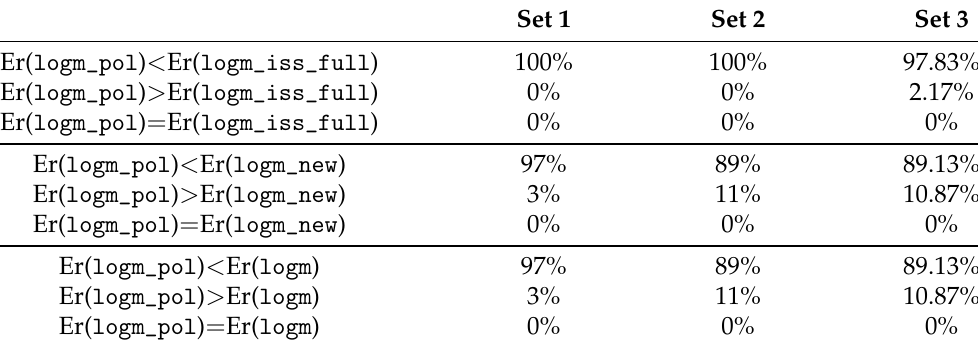
Table 5. Relative error comparison, for the three sets of matrices, of logm_pol versus logm_iss_full , logm_new , and logm